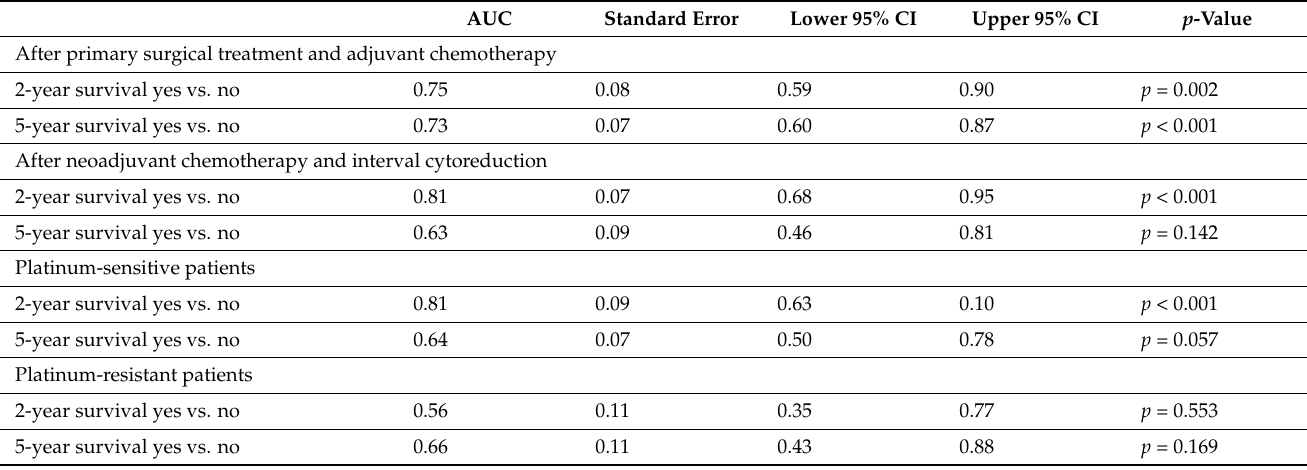
Table A2. Assessment of serum HE4 prognostic value after the third course of second-line chemotherapy.